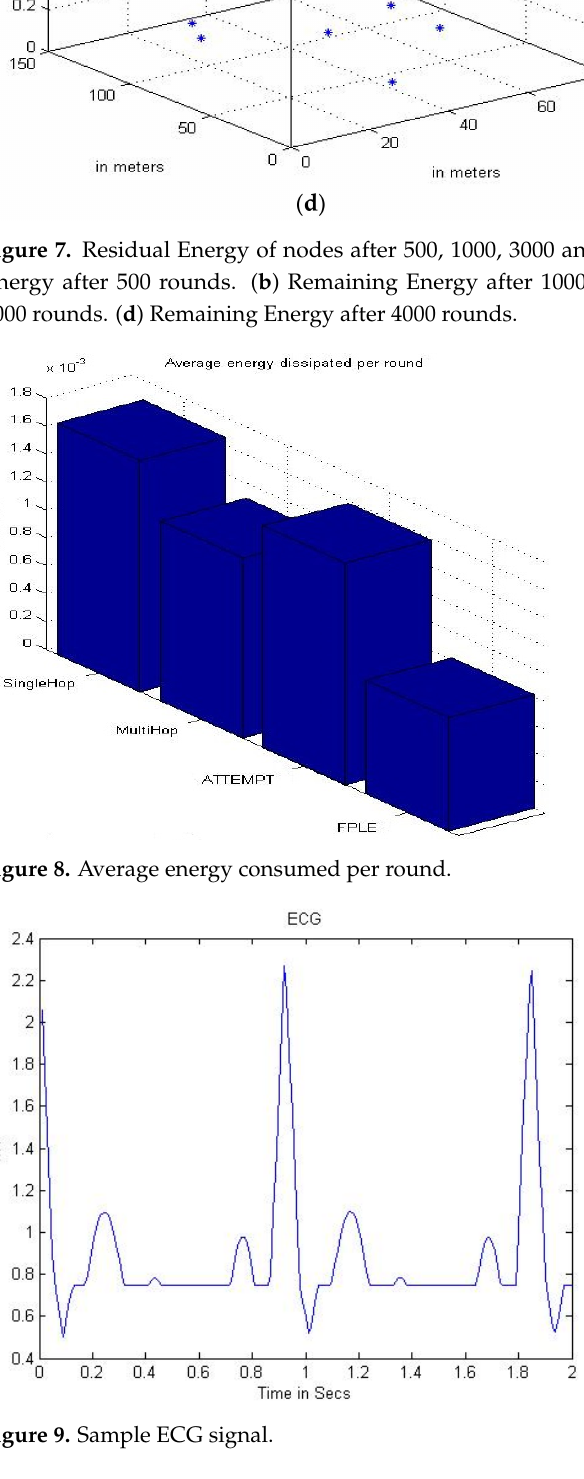
Figure 10. Experimental Setup for validation of the algorithm.